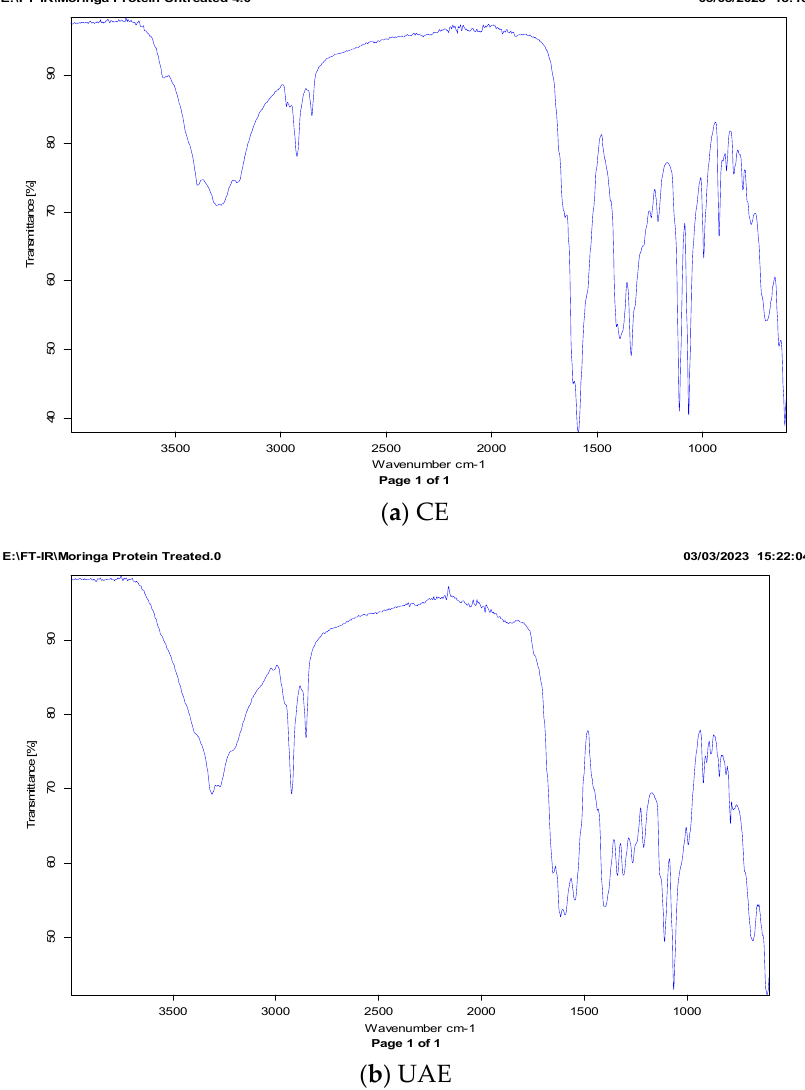
Figure 4. FT-IR spectra of M. oleifera seed protein (MOSP) isolate from conventional extraction ( a ) and ultrasonic-assisted extraction ( b ).